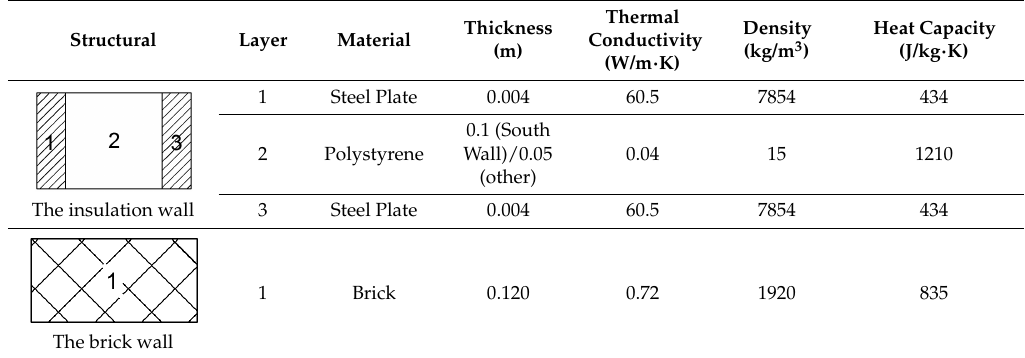
Table 2. Material properties of the PCM.